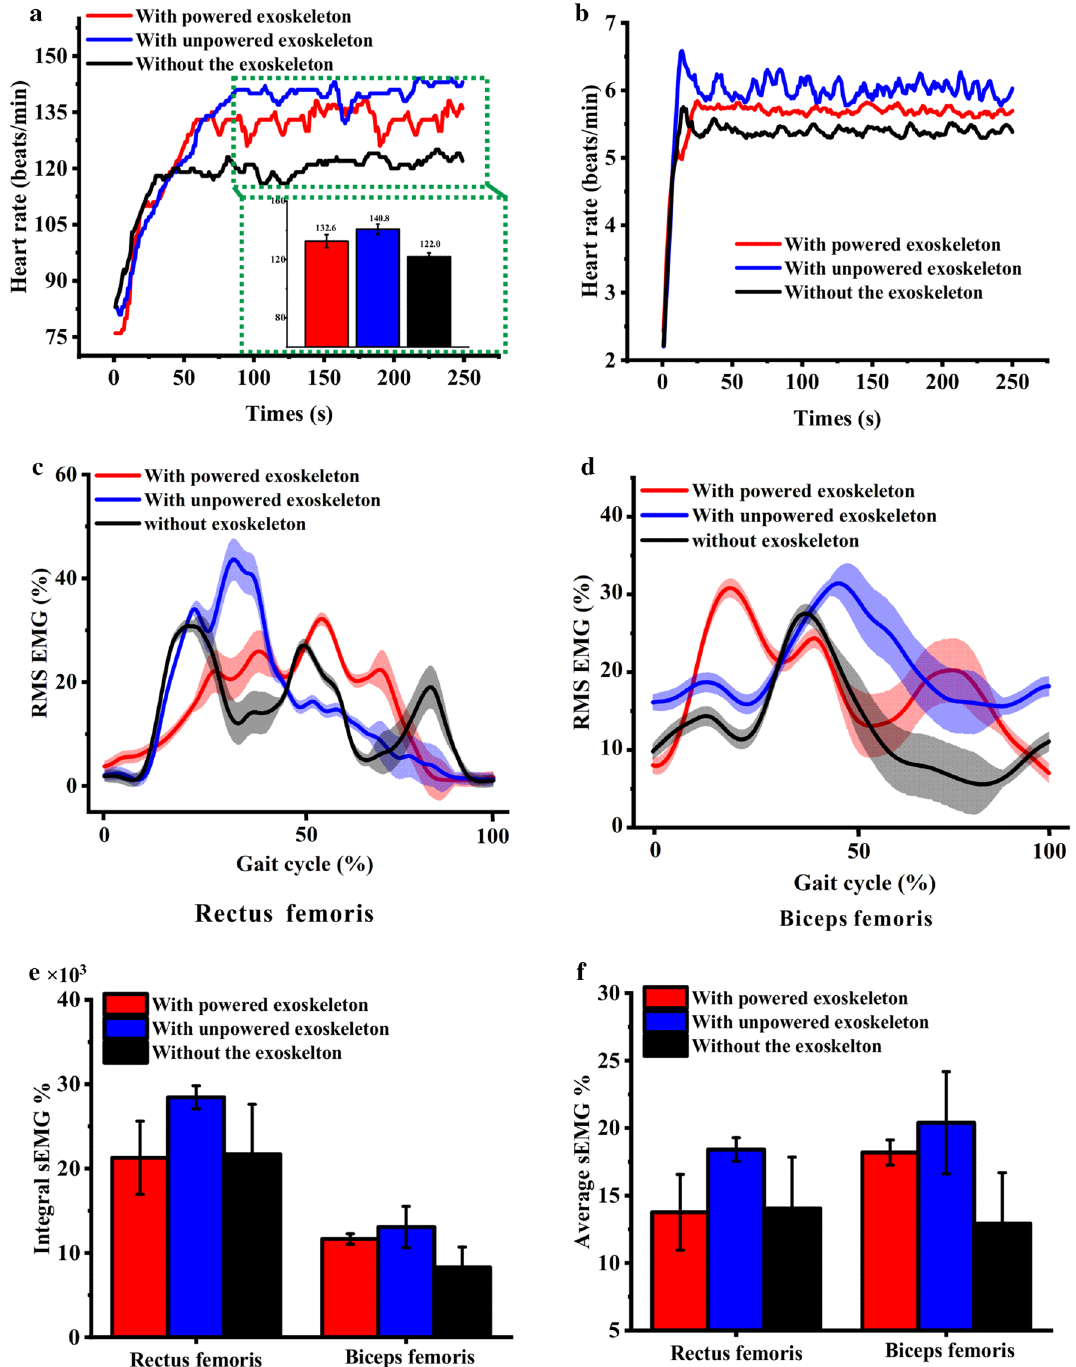
Figure 8. Kinematics and human–robot interaction data of the subject with three conditions at the advanced phase. ( a ) Heart rate value of the subject with three conditions, the average HR were inserted in green box; ( b ) MET changes in the subject with time during three conditions; ( c ) RMS sEMG of RF with three conditions; and ( d ) RMS sEMG of BF with three conditions, the shaded area represent the standard deviation. ( e ) IEMG of RF and BF muscles with three conditions; and ( f ) AEMG of RF and BF muscles with three